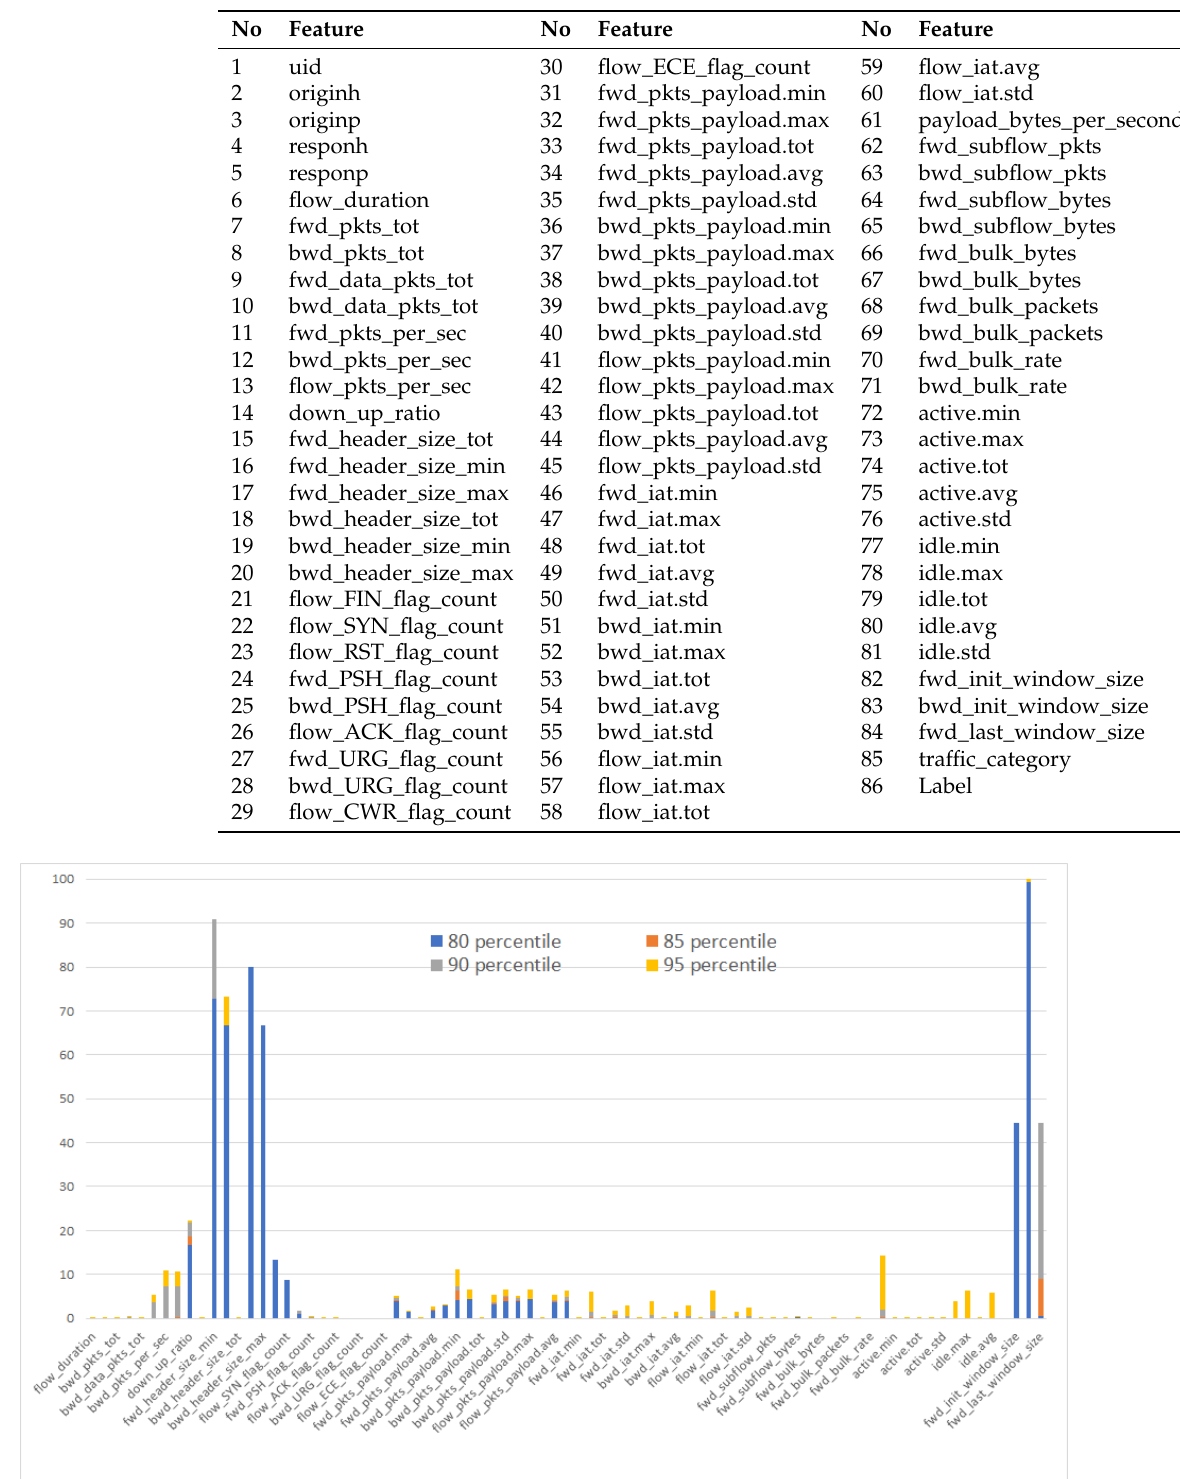
Table 3. List of features in HIKARI-2021.